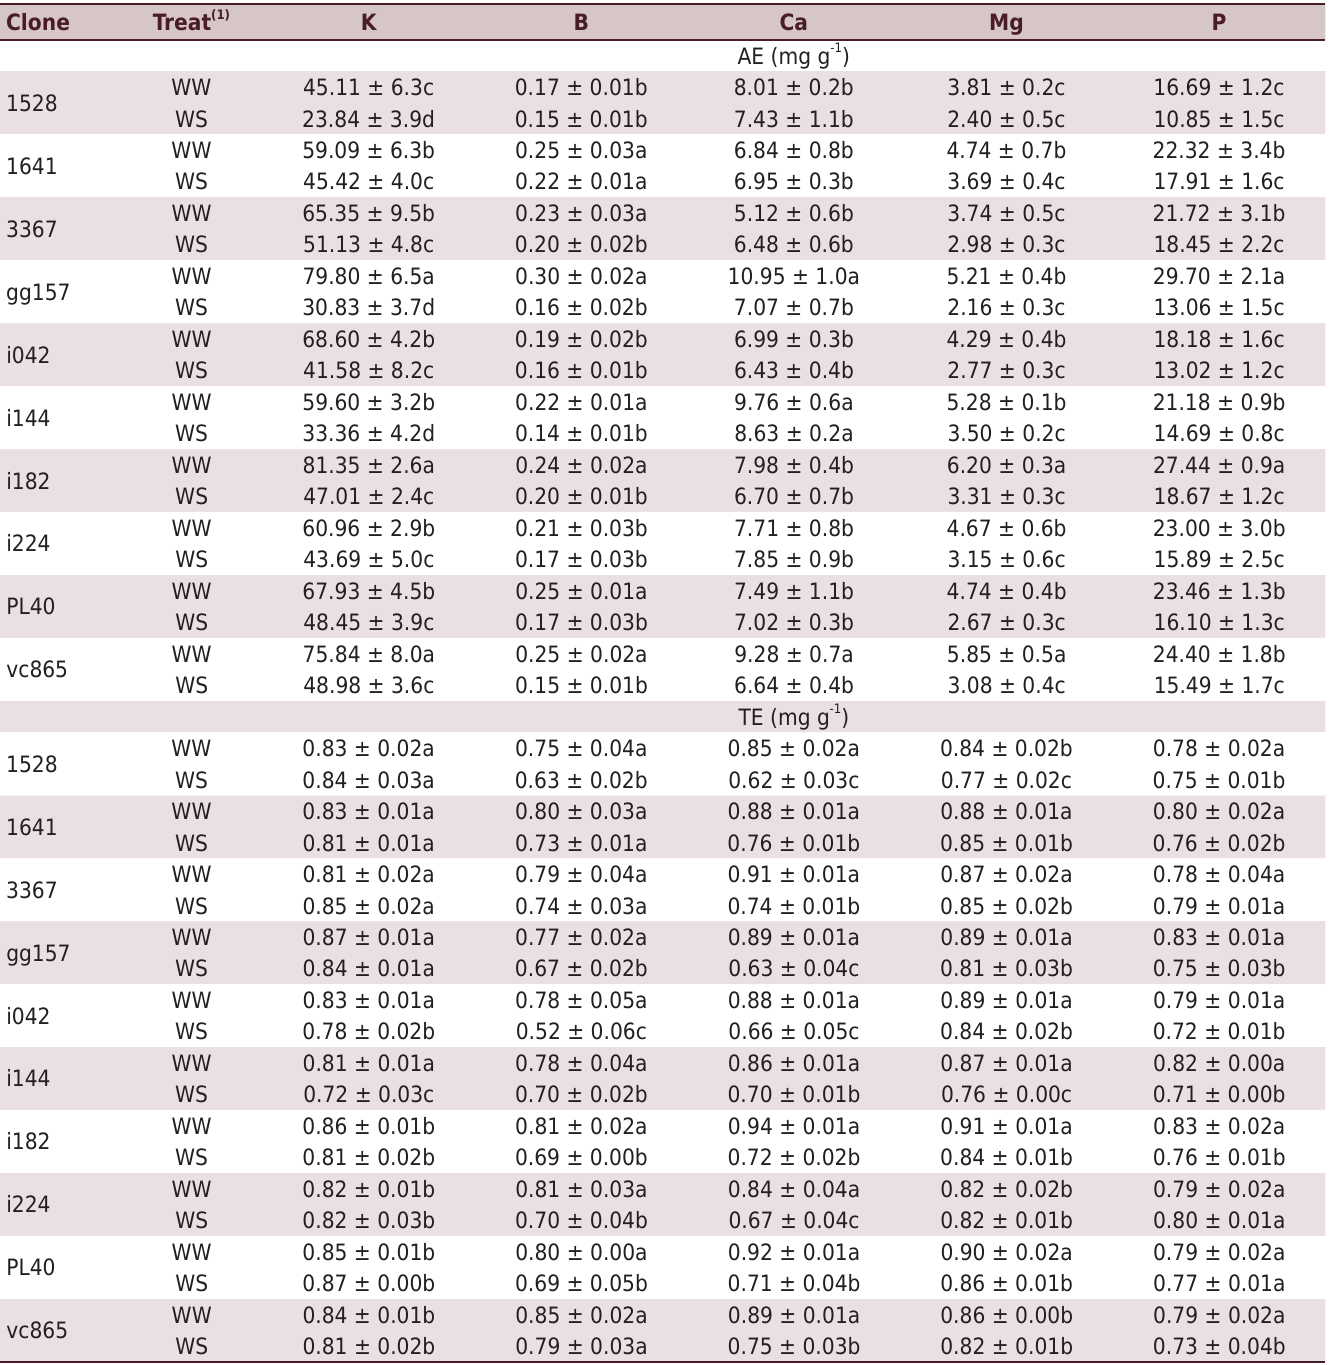
Table 2. Absorption efficiency (AE) and translocation efficiency (TE) of nutrients in ten Eucalyptus clones under well-watered (WW) or water stress (WS) conditions. Data indicate the mean ± SE (n =4). Means followed by the same letter in a column did not differ significantly by the Scott Knott test (p ≥